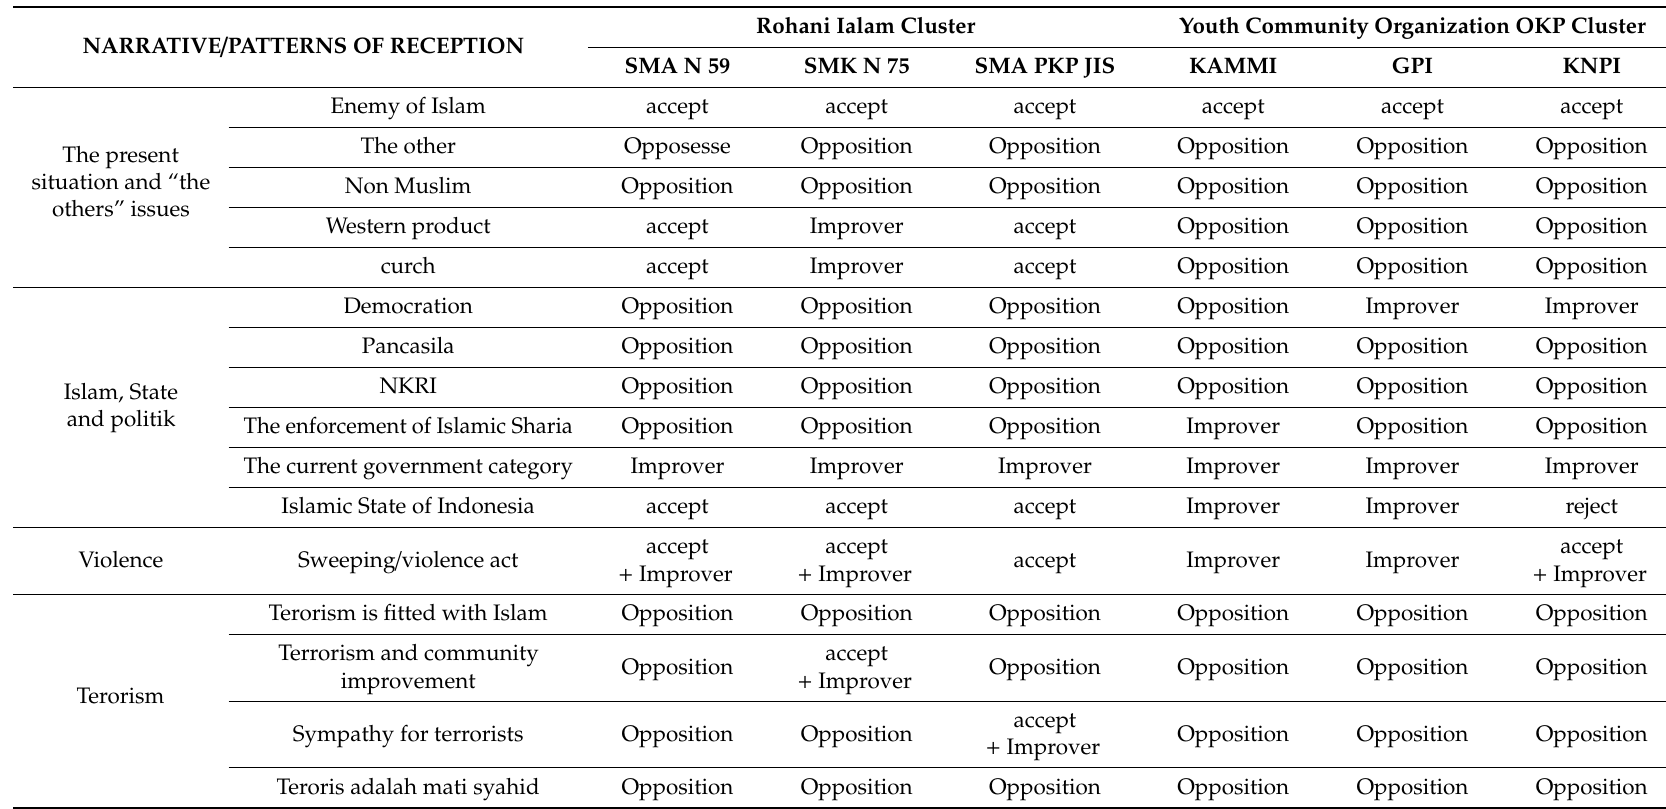
Table 2. Reception Pattern of Radicalism and Terrorism Narrative in Jakarta Metropolitant: Rohani Islam (Rohis) and Youth Community Organisation (OKP) Cluster Rohani Ialam Cluster NARRATIVE / PATTERNS OF RECEPTION KAMMI GPI KNPI Enemy of Islam accept accept accept accept accept accept The other Opposesse Opposition Opposition Opposition Opposition Opposition The present situation and “the Non Muslim Opposition Opposition Opposition Opposition Opposition Opposition others” issues Western product accept Improver accept Opposition Opposition Opposition curch accept Improver accept Opposition Opposition Opposition Democration Opposition Opposition Opposition Opposition Improver Improver Opposition Opposition Opposition Opposition Opposition Opposition NKRI Opposition Opposition Opposition Opposition Opposition Opposition Islam, State and politik The enforcement of Islamic Sharia Opposition Opposition Opposition Improver Opposition Opposition The current government category Improver Improver Improver Improver Improver Improver accept accept accept Improver Improver reject accept accept accept Violence Sweeping / violence act + Improver + Improver accept Improver Improver + Improver Terorism is fitted with Islam Opposition Opposition Opposition Opposition Opposition Opposition Terrorism and community accept Opposition + Improver Opposition Opposition Opposition Opposition improvement Terorism accept Sympathy for terrorists Opposition Opposition + Improver Opposition Opposition Opposition Teroris adalah mati syahid Opposition Opposition Opposition Opposition Opposition